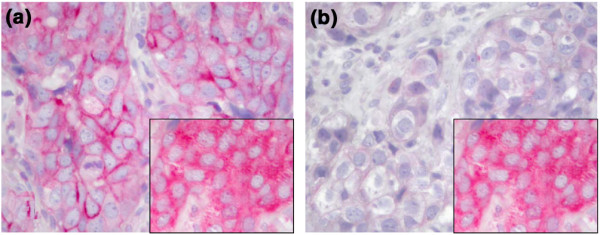
Representative immunohistochemical staining of a Her-2/neu and focal adhesion kinase (FAK)-overexpressing tumor for phospho-Src Tyr-215 and phospho-Src Tyr-416. Light micrograph displaying (a) strong phospho-Src Tyr-215 and (b) missing phospho-Src Tyr-416 staining in serial sections of a Her-2/neu-overexpressing and FAK-overexpressing invasive breast cancer sample as analyzed by immunohistochemistry. Inset: immunohistochemical staining showing FAK overexpression of the same sample. Original magnification, × 400.